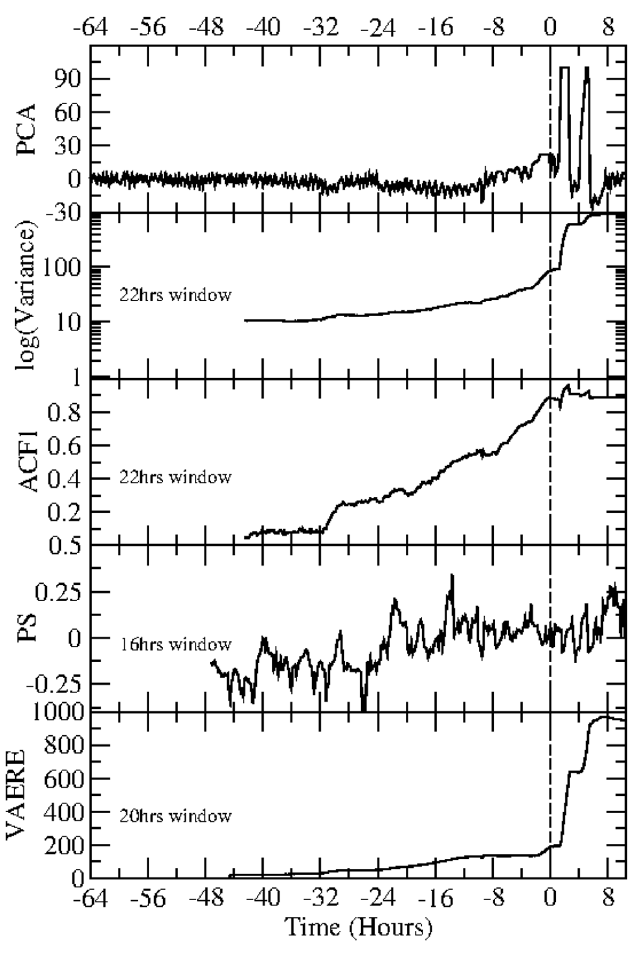
Fig. 4. Multivariate EWS analysis of the temperature failure with PCA and four indicators: variance, auto-correlation function, power spectrum and variational autoencoder. The moment of the failure (when the supply air temperature increases anomalously for the fi rst time) is 9:30 AM of the 27th of January 2019. Plot starts at 5:30AM of the 25th of January, 64 hours prior to the failure. Variance is shown in logarithmic scale to make the increase prior to failure more visible. Window sizes used: 22 hours for variance and ACF1, 16 hours for PS and 20 hours for